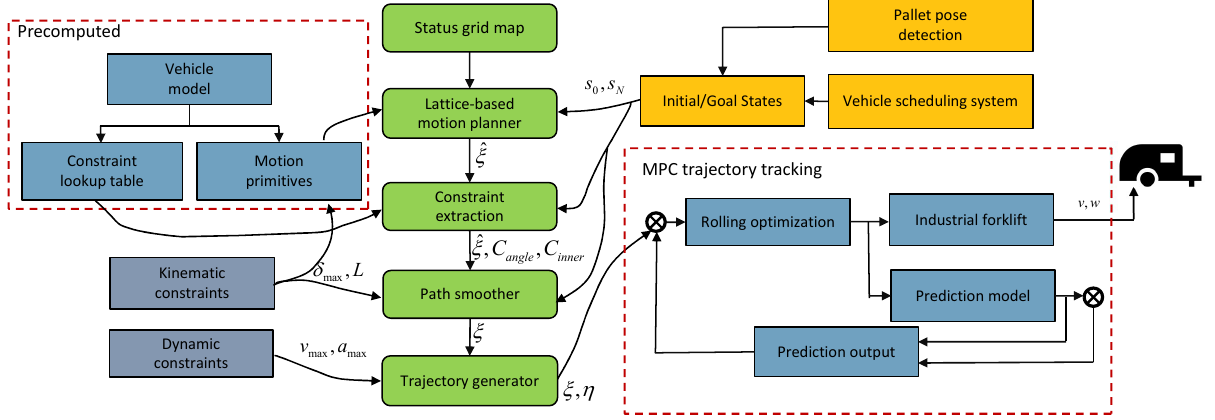
Figure 2. Navigation system framework. The variables s 0 and s N indicate the starting pose and target pose of the vehicle, respectively; δ max indicates the maximum steering angle; L indicates the distance between the front and rear axles of the forklift truck, v max and a max , respectively, as constraints on velocity and acceleration in the forward direction. The ξ and η denote two collection of points in the state space and the control space, respectively, C angle is the angle constraint, and C inner is the inner constraint. A pre-computed constraint lookup table was used to extract a set of position and angle inequality constraints for the vehicle